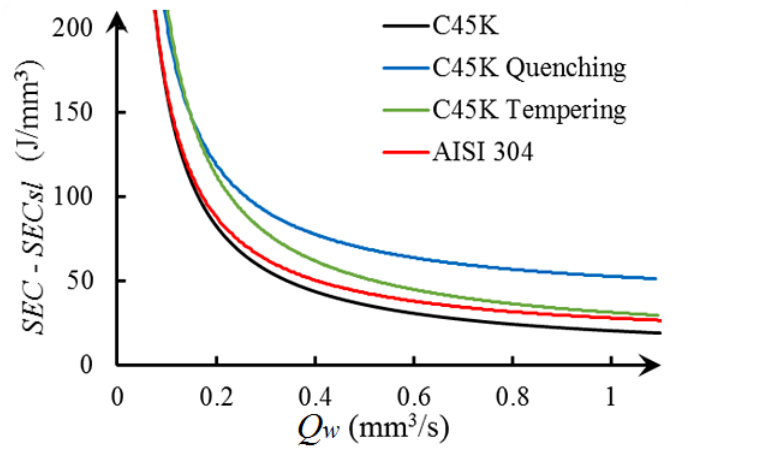
Figure 4. Specific energy consumption and material-removal